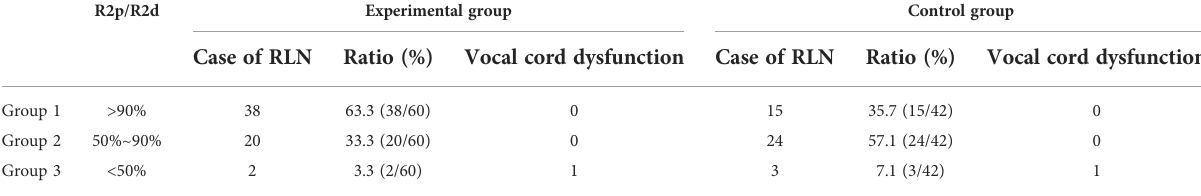
TABLE 3 Variation of recurrent laryngeal nerve (RLN) signal amplitude and vocal cord movement after level VI lymph node dissection. R2p/R2d